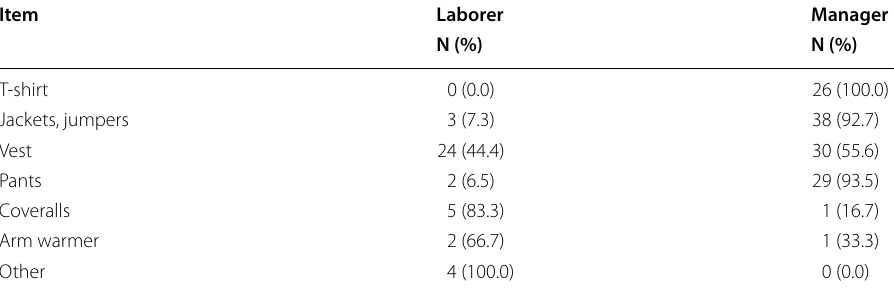
Table 7 Type of workwear given by the company